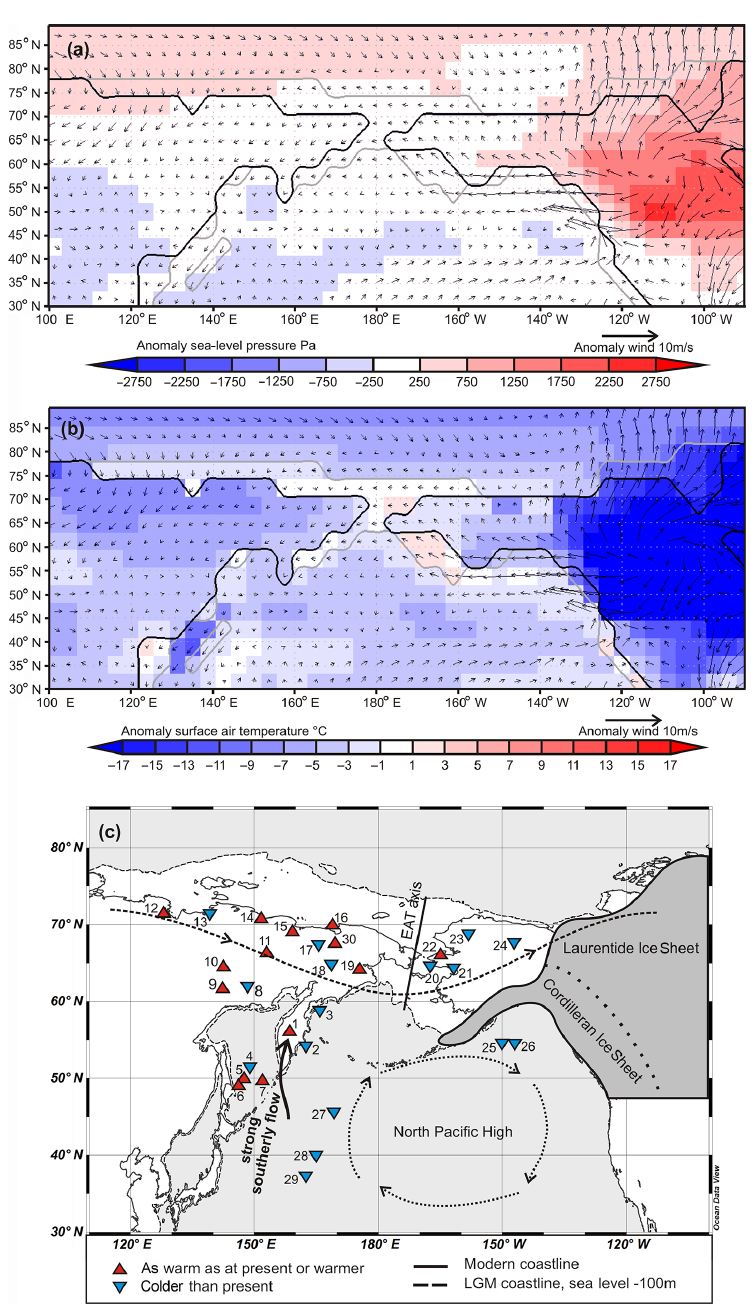
Figure 4. Comparison of proxy- and model-based inferences regarding glacial anomalies in temperature and atmospheric circulation over the N Pacific and Beringia relative to present. (a) COSMOS simulation for the JJA SLP anomaly over Beringia and the N Pacific during the LGM (21ka) relative to PI. Arrows represent the wind anomaly. Note that the model predicts a northerly anomaly over Kamchatka. (b) COSMOS- simulation for SAT and wind anomalies during JJA. (c) Compilation of proxy-based anomalies of summer air temperature in Beringia and of summer–autumn SST reconstructions in the N Pacific for the LGM. Sites and corresponding references are given in the Appendix A. Dotted arrows sketch the general summer anticyclone over the N Pacific, the NPH. Based on MAT ifs , the NPH and associated southerly winds over the subarctic NW Pacific were stronger than at present (represented by solid arrow). The dashed line marks the approximate average position of the East Asian Trough (EAT) during present day summers (Mock et al., 1998). Grey shaded areas represent the extent of ice sheets during the